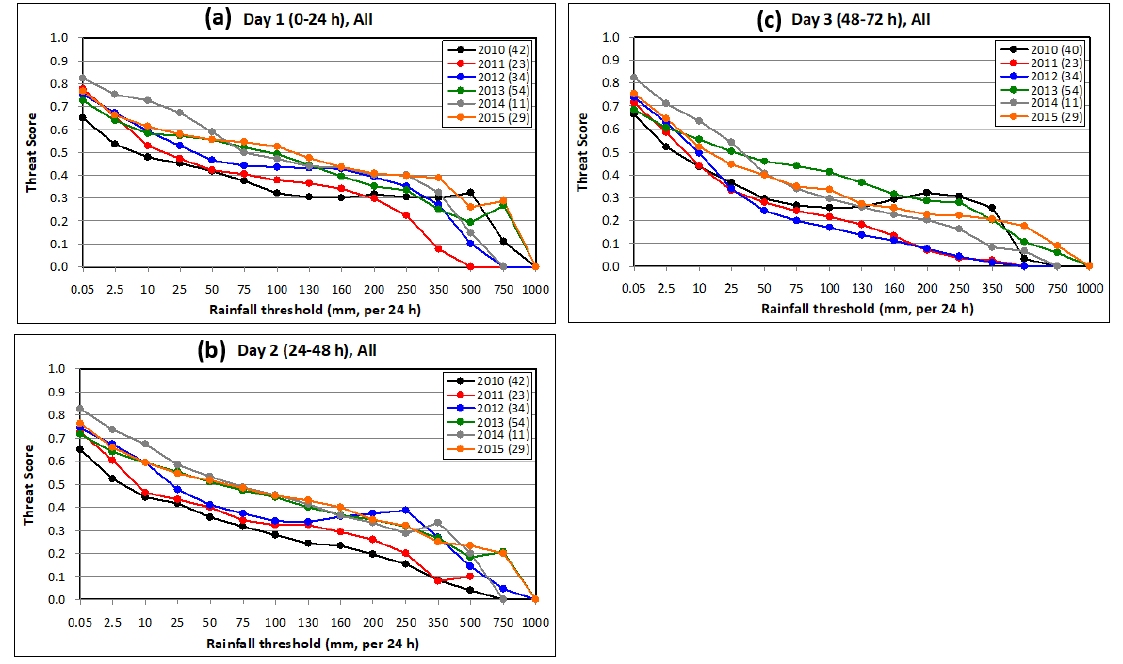
Figure 2. The overall TS of 24 h QPFs for ( a ) day 1 (0–24 h), ( b ) day 2 (24–48 h), and ( c ) day 3 (48–72 h) by the 2.5 km CReSS model in Taiwan as a function of rainfall threshold (mm) from all events in individual seasons between 2010 and 2015 (see insert). The parentheses in insert give the number of 24 h periods included for verification in each season, and they cover the warning periods issued by the CWB for each TC case, as defined in Refs. [30,31].